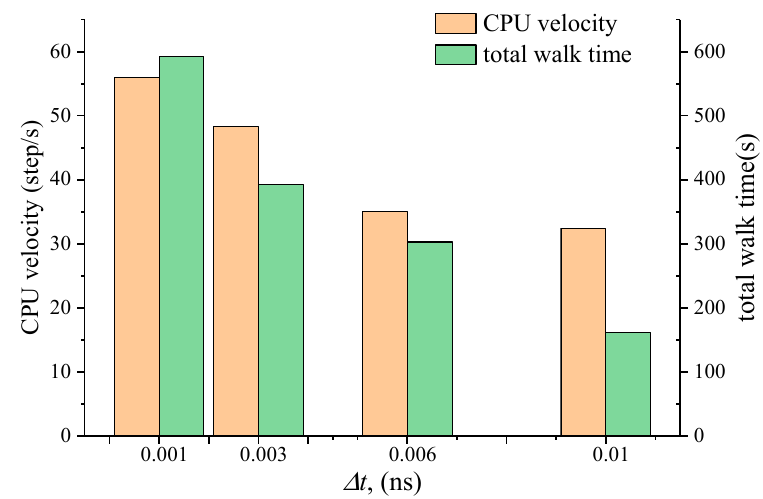
6 of 12 Figure 3. Aggregates concentration with time range (L = 60 ns). The average value of the cluster distribution with different timesteps is taken as a stable value (cid:2022)(cid:4666)(cid:1872)) to solve the error (cid:1857) (cid:3045) (cid:4666)(cid:1872)) of random operation with different timesteps: (cid:1857) (cid:3045) (cid:4666)(cid:1872)) = |(cid:3048)(cid:4666)(cid:3047))(cid:2879)(cid:3093)(cid:4666)(cid:3047))| (cid:3093)(cid:4666)(cid:3047)) , (13) where (cid:1873)(cid:4666)(cid:1872)) represents the cluster distribution at each timestep. The results of errors are